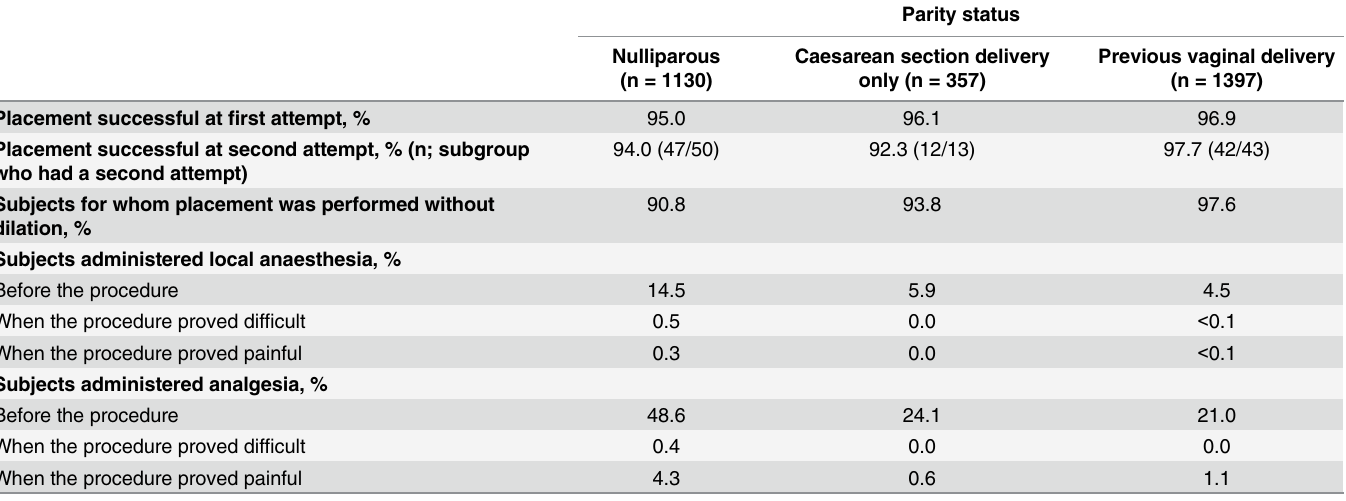
Table 4. Placement Success Rates, Use of Dilation and Administration of Pain Medication on Placement (Both Treatment Groups Combined) by Parity Status (Full Analysis